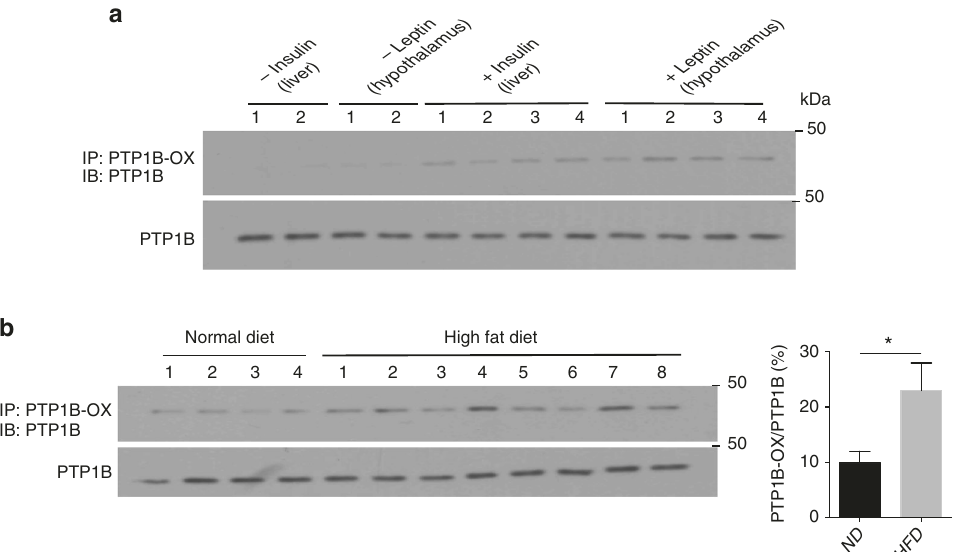
Fig. 8 Stabilization of oxidized PTP1B in diet-induced obese mice. a Oxidation of PTP1B was measured in liver and hypothalamus samples obtained from mice following the administration of insulin and leptin, respectively ( n = 4 in each group) using a pulldown assay with the PTP1B-OX-speci fi c intrabody scFv45. b Oxidation of PTP1B was measured in liver samples obtained from mice fed normal or high fat diet (HFD) using a pulldown assay with the PTP1B- OX-speci fi c intrabody scFv45 ( n = 4 or more in each group). All immunoblots are representative of tissue lysates generated from at least three independent animals for each condition ( n = 3). Immunoblots were quanti fi ed using ImageJ software. Quantitation includes all independent data from the respective experiments and is presented as the mean ± s.e.m. Statistical analysis was performed using two-way ANOVA (* p <